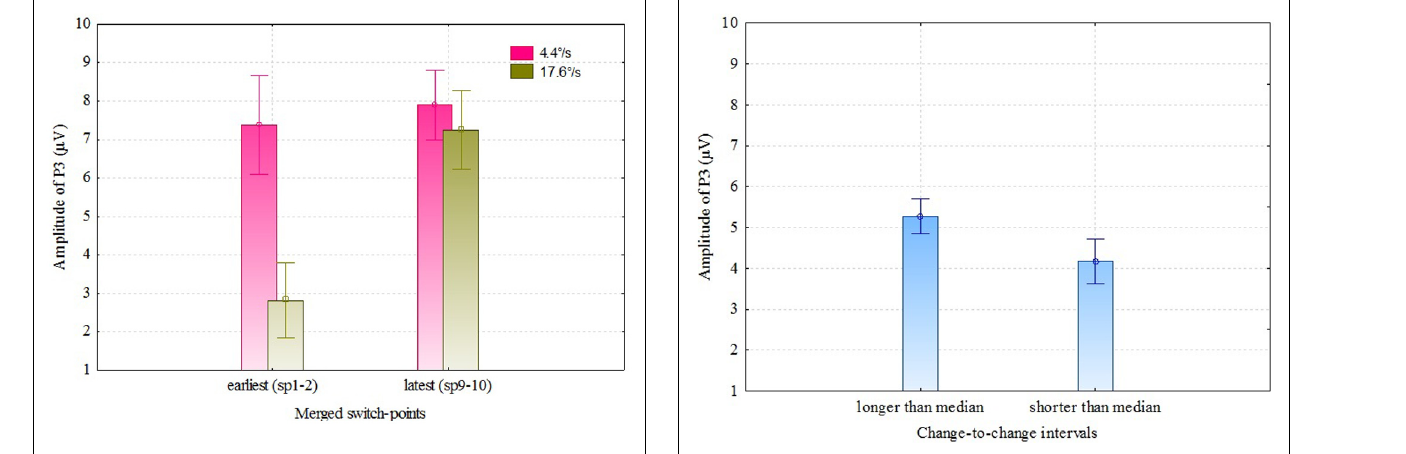
FIGURE 6 | P3 amplitudes (parietal region) by longer and shorter than median change-to-change intervals (TTI). Vertical bars denote ± standard error.